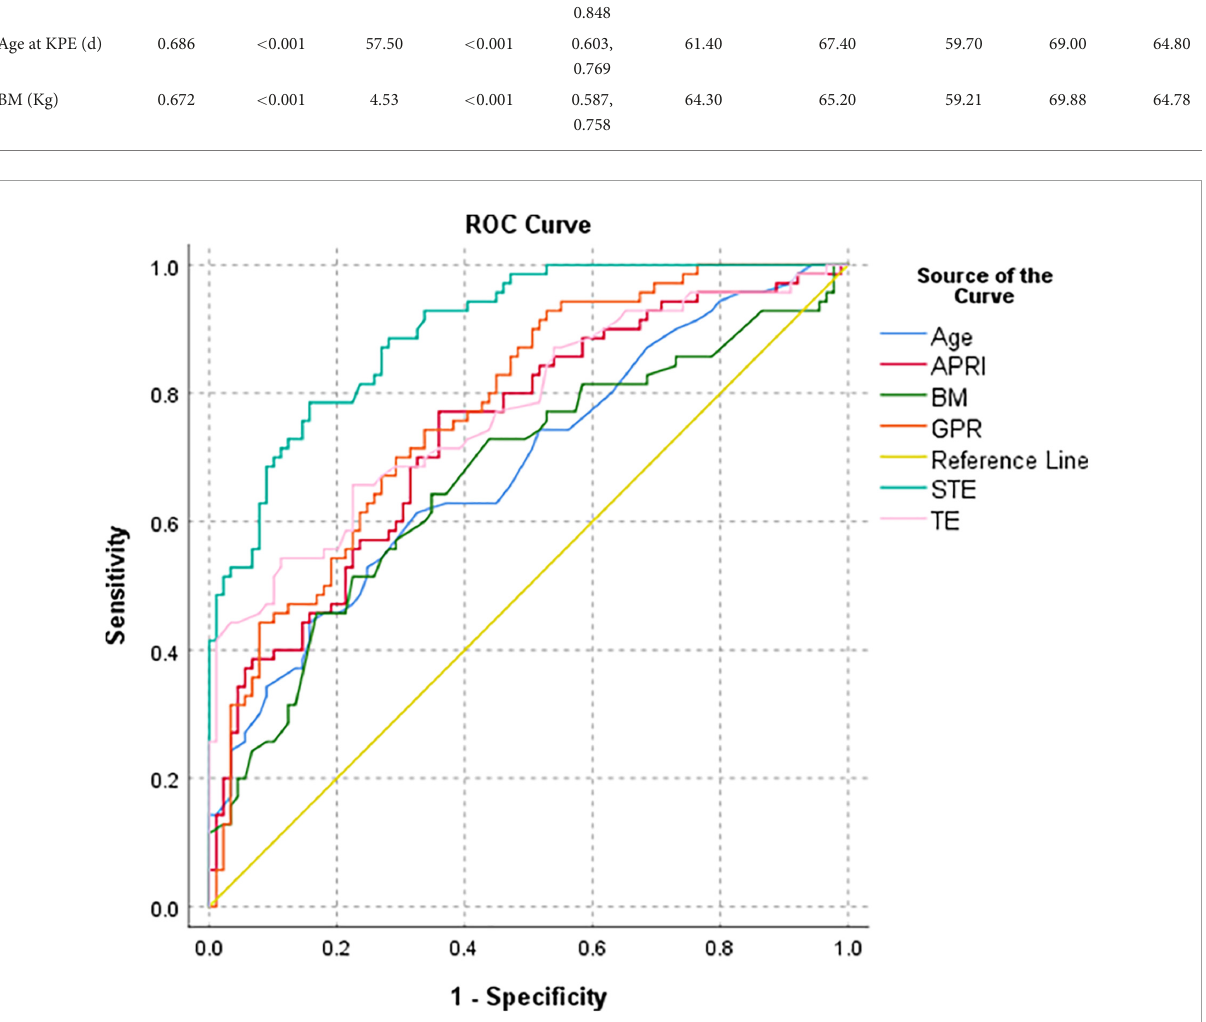
FIGURE7 Receiver operator characteristic curve of various parameters to distinguish cirrhosis (F4) in all BA